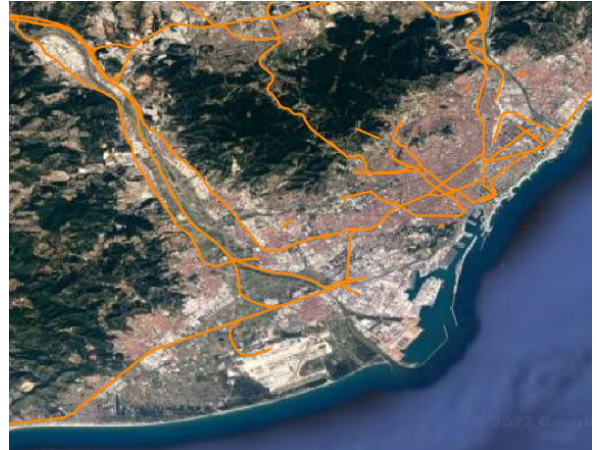
Figure 1 . Study area and railway networks.